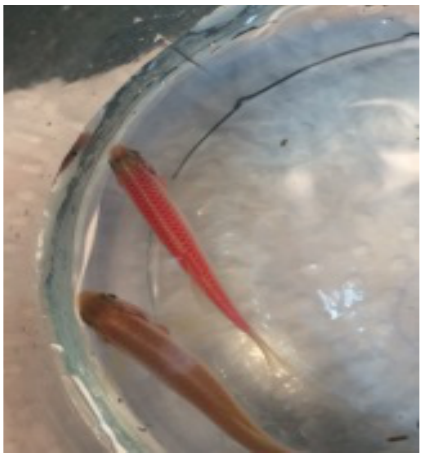
Fig. 1 . Red and cream zebrafish